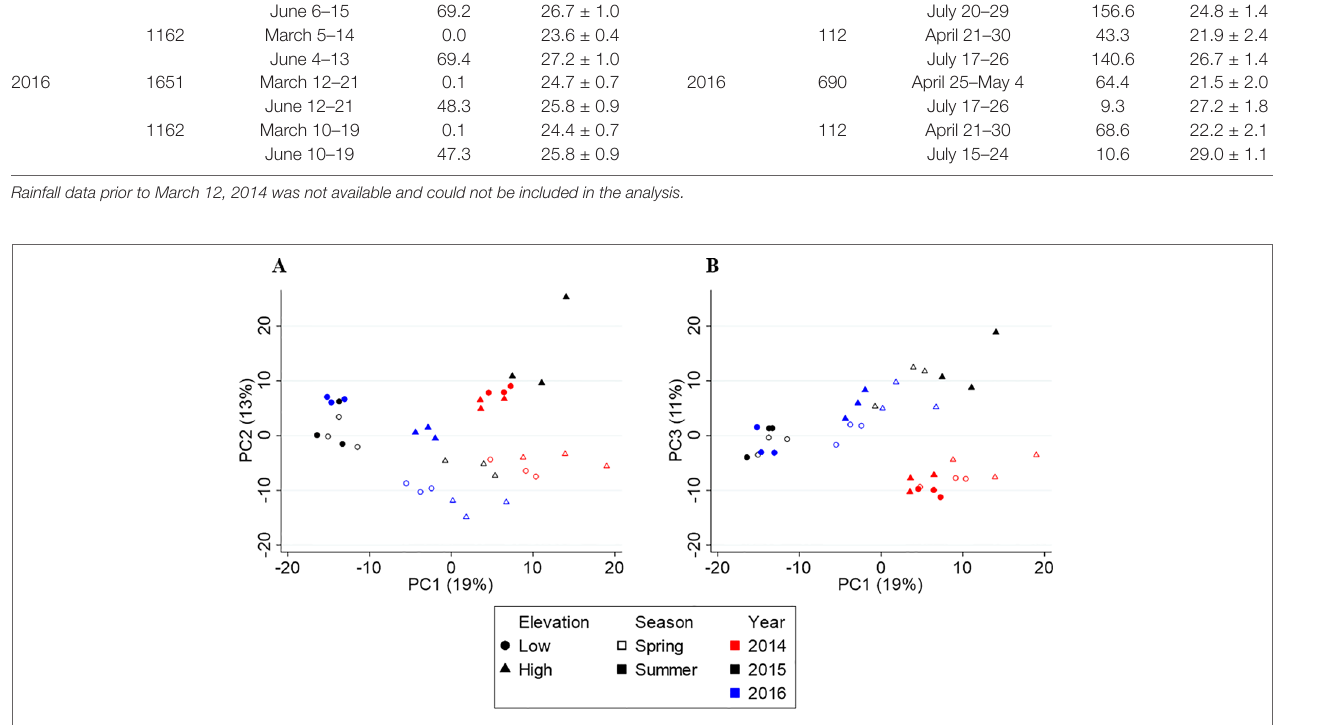
Frontiers in Plant Science |